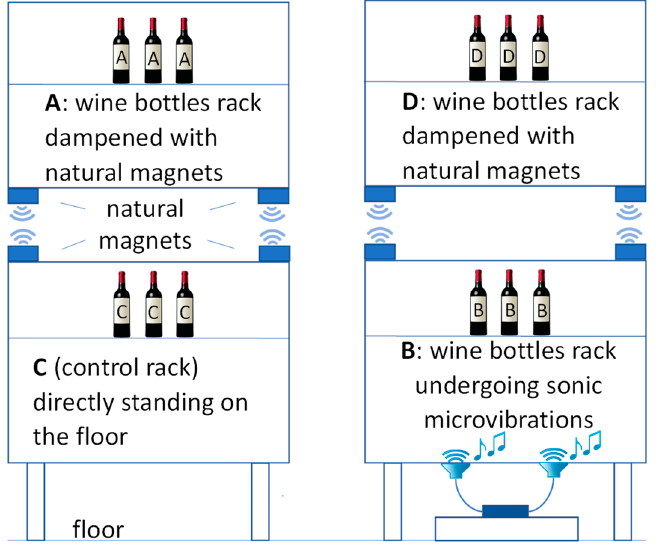
Figure 1. Configuration of the shelves hosting the wine bottles during the storage. The image shows the bottles for the two shelves used in the